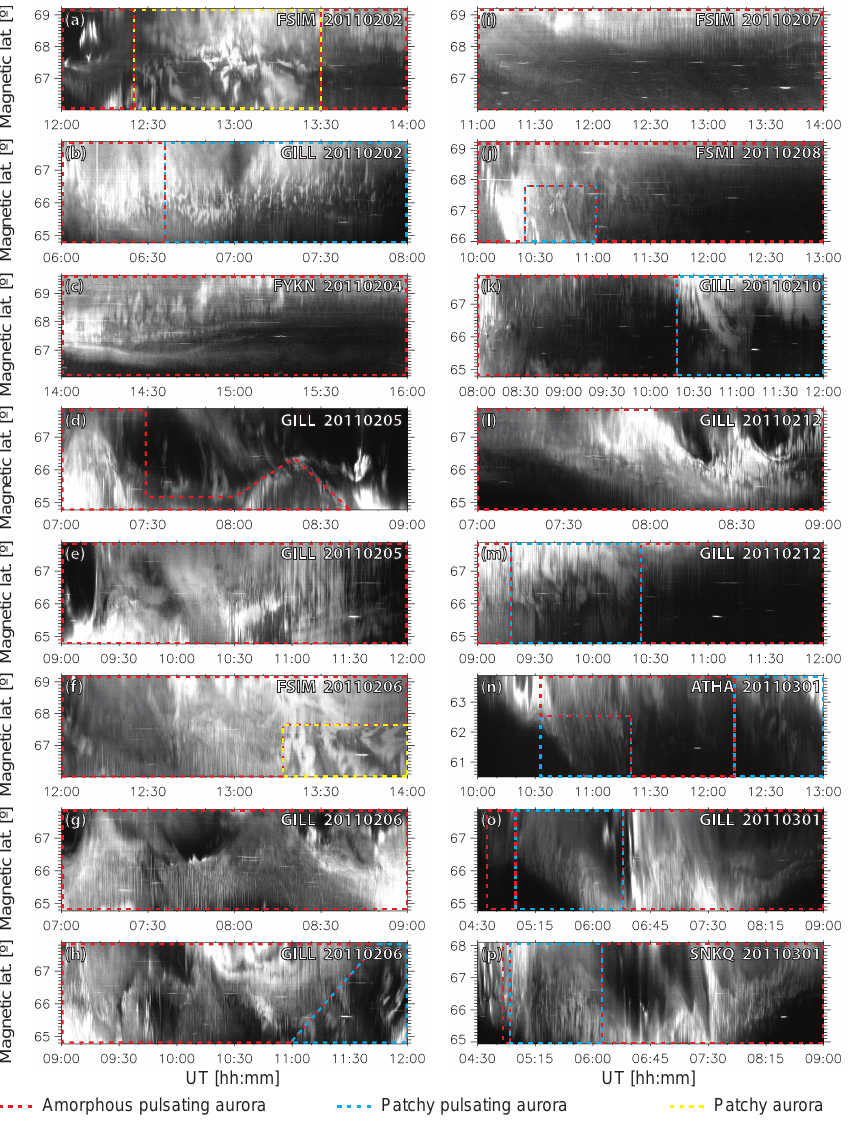
Figure 4. Sixteen pulsating aurora events where regions of amorphous pulsating aurora, patchy pulsating aurora, and patchy aurora are approximately outlined in red, blue, and yellow, respectively. The outlined regions designate only the most prominent types in the keogram and do not imply that no other types are simultaneously present within the ASI field-of-view. Videos of the associated ASI data are included in Grono